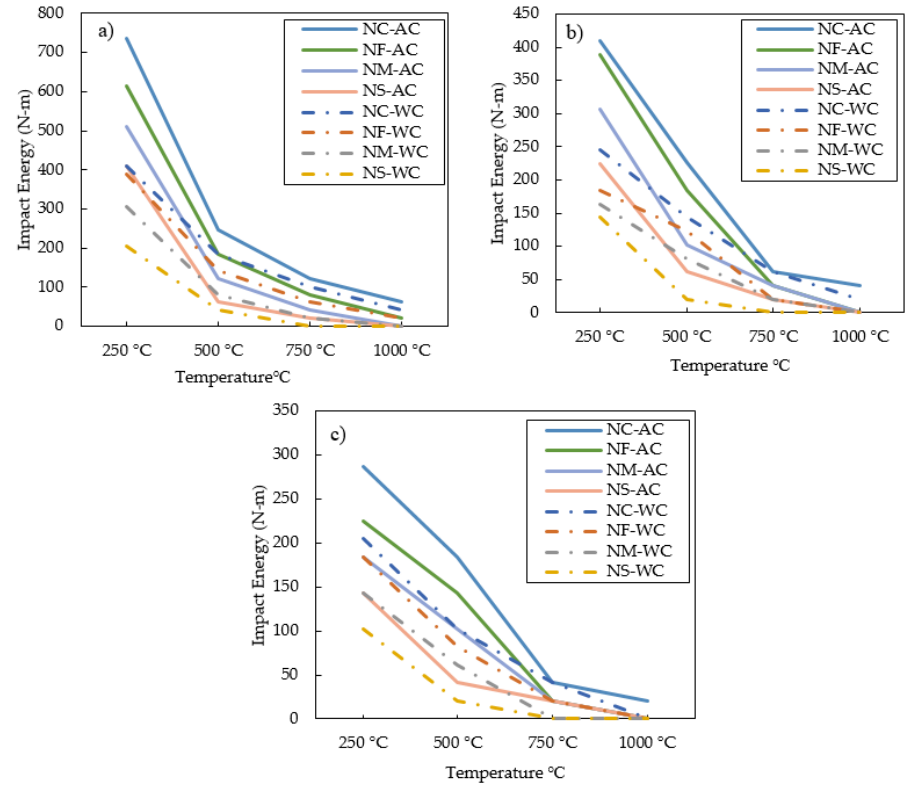
Figure 3. Impact energy versus temperature of M20 grade concrete with various percentages of nanomaterials: ( a ) 10%; ( b ) 20%; ( c ) 30%.